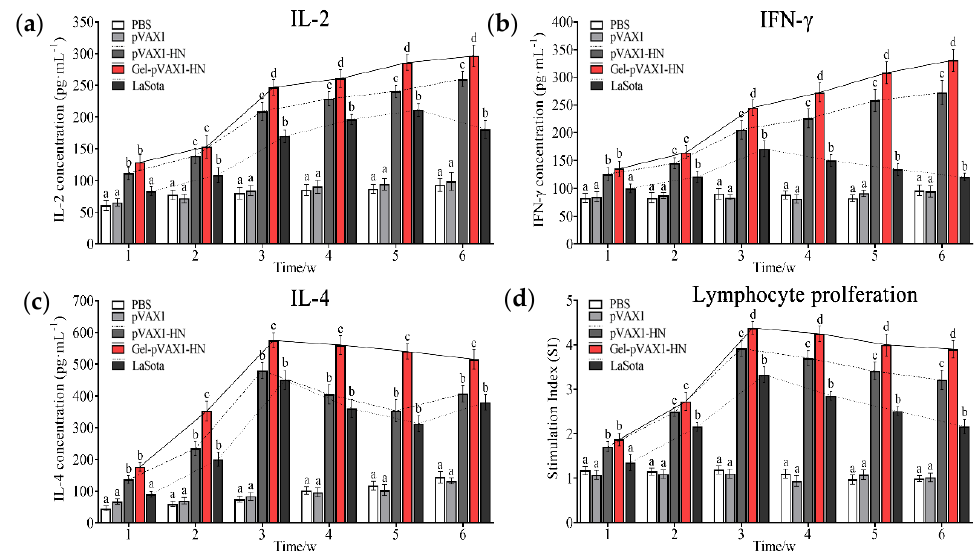
Figure 5. Cellular immune response assay of the NDV DNA hydrogel vaccine. After inoculation, the blood samples were collected at each time point for the next assay. ELISA assay detected the serum levels of IL-2 ( a ), INF- γ ( b ), and IL-4 ( c ). ( d ) Ratios of lymphocyte proliferation in immunized chickens. The results are expressed as the mean ± SD of three independent experiments. Bars at the same week with different superscripts mean significant differences ( p < 0.05).